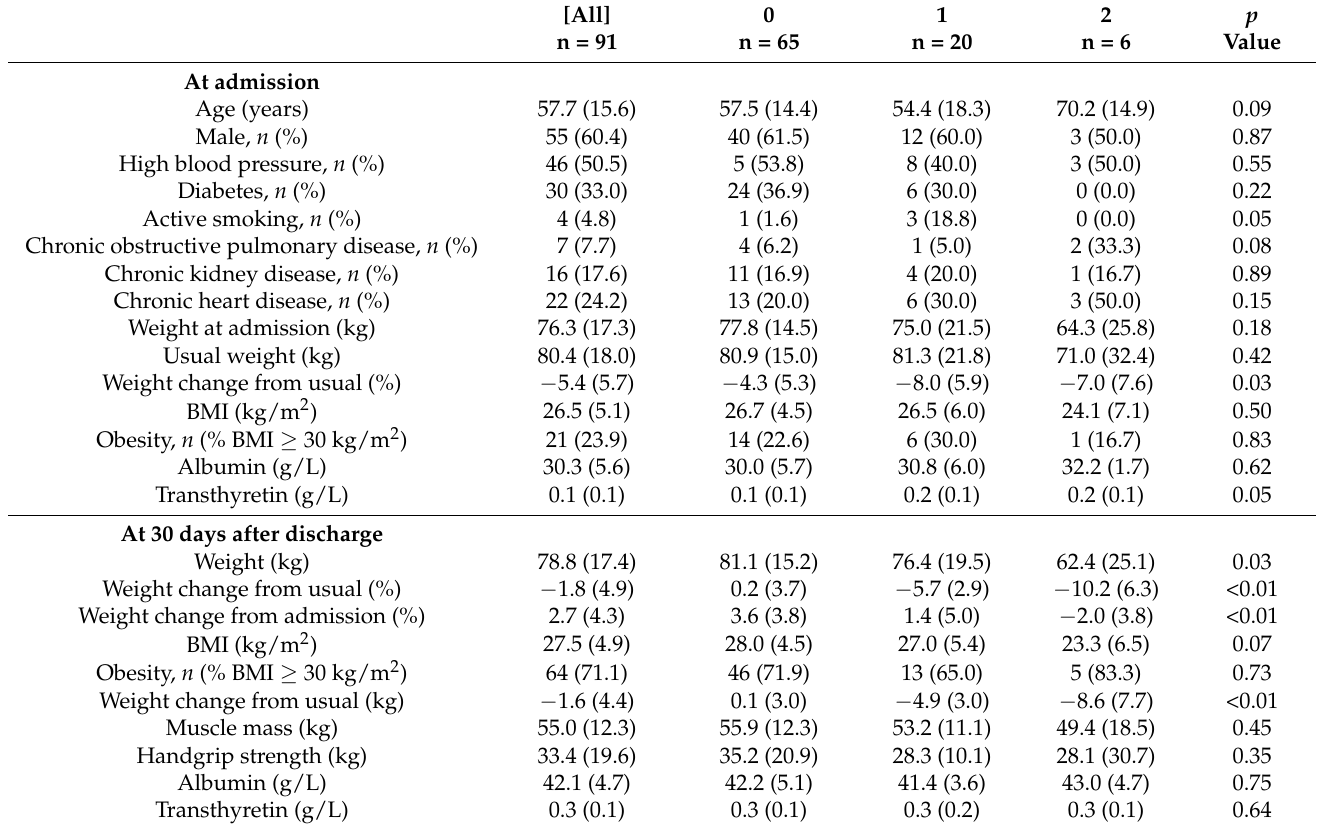
Table 1. General characteristics and nutritional parameters of COVID-19 patients according to GLIM nutritional status 30 days after hospital